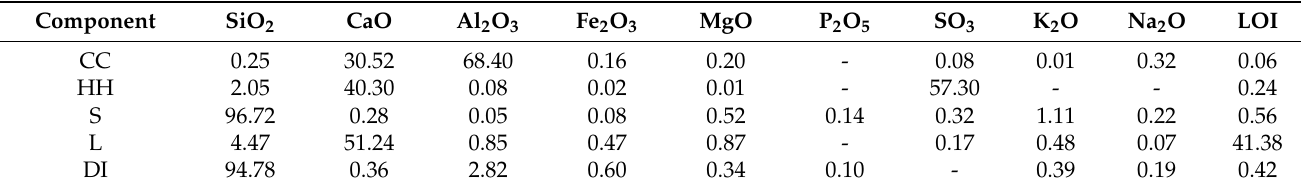
Table 1. Chemical composition of raw materials (wt./%).